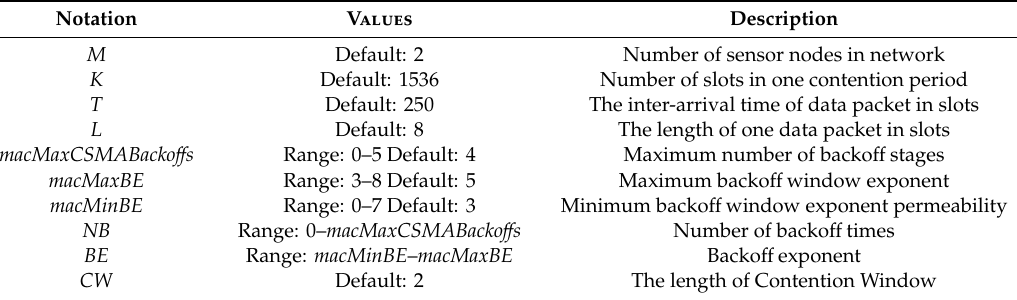
Table 1. Basic notations.